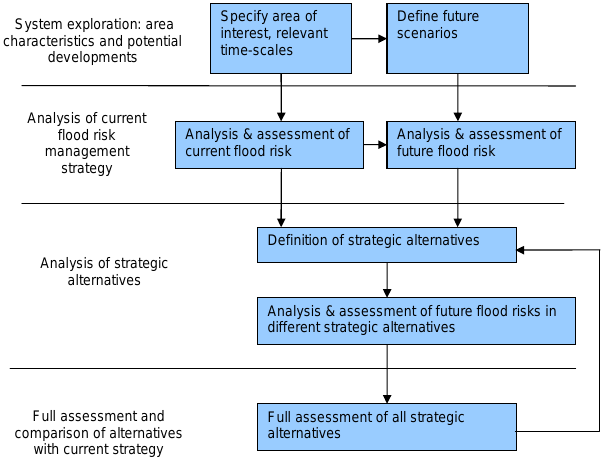
Figure 1. Procedure (steps and tasks) for an exploratory policy analysis in behalf of long-term 4 Fig. 1. Procedure (steps and tasks) for an exploratory policy analy- sis in behalf of long-term flood risk management planning (after De Bruijn et al.,